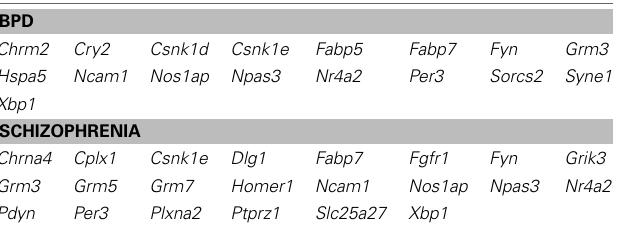
Table 2 | Enriched miRNA binding sites in genes that are upregulated and downregulated in maternal